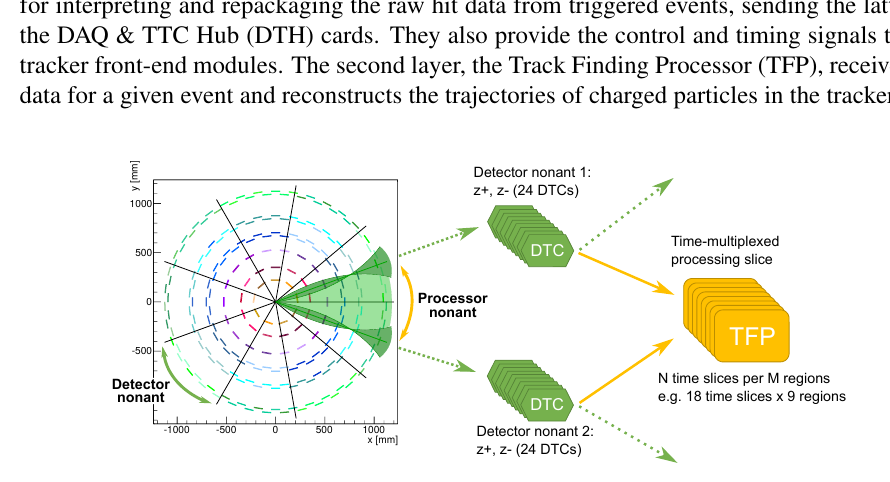
Figure 1: CMS tracker back-end system architecture using two neighboring detector nonants DTCs to time-multiplex and duplicate stub data across processing nonant boundaries for transmission to the Track Finding Processors (TFPs)